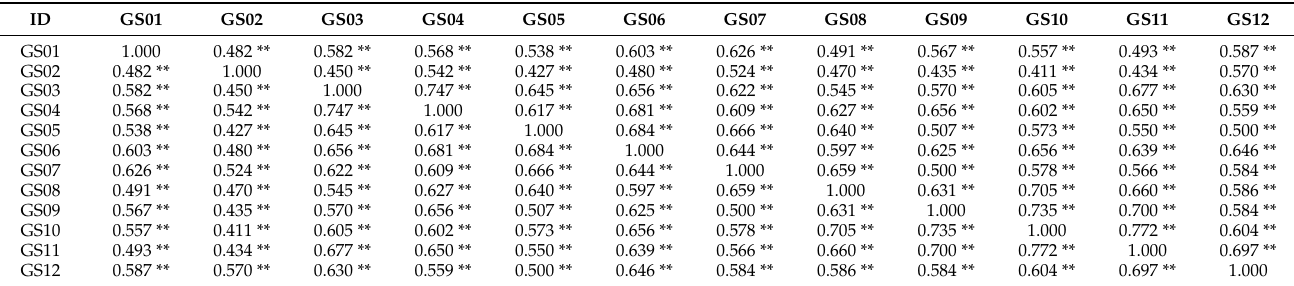
Table 4. Correlation